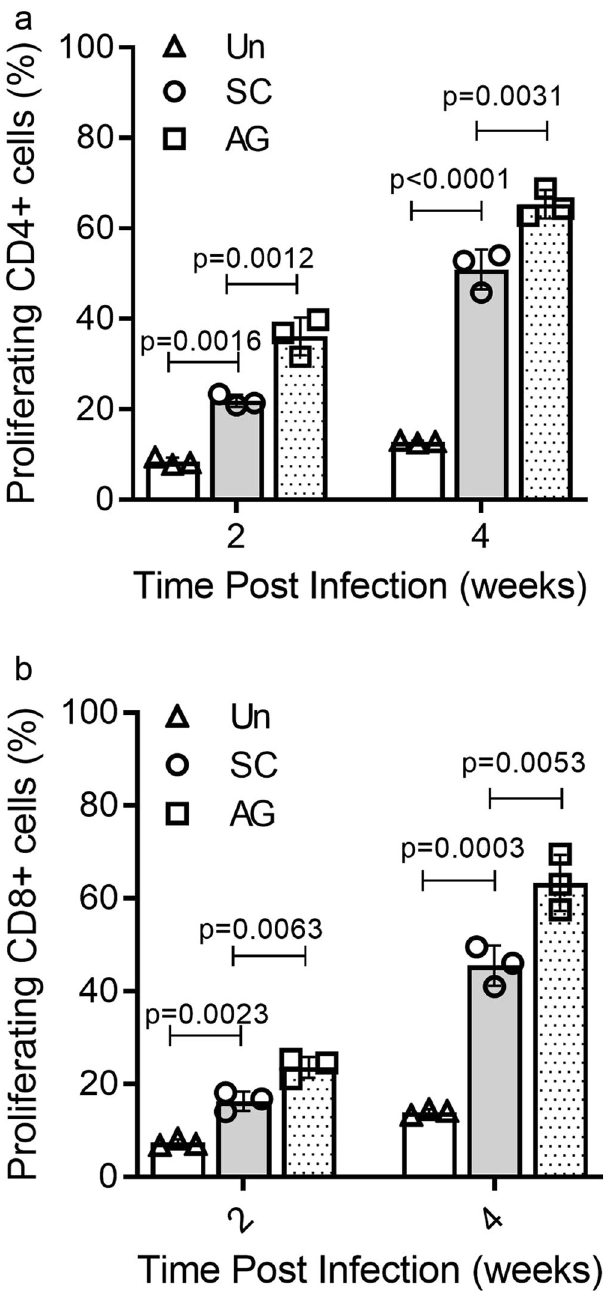
Fig. 2 Activation of spleen CD4 + and CD8 + T cells in Mtb-AG or Mtb-SC infected rabbits. The percentage of proliferating CD4 + ( a ) and CD8 + ( b ) T cells was determined at 2 and 4 weeks by fl ow cytometry analysis. Single- cell suspensions of the spleen were used and stained with cell-speci fi c antibodies after in vitro stimulation with heat-killed H37Rv or unstimulated (Un). n = 3 rabbits per group. Data were analyzed by one-way ANOVA with Tukey ’ s post correction for multi-group